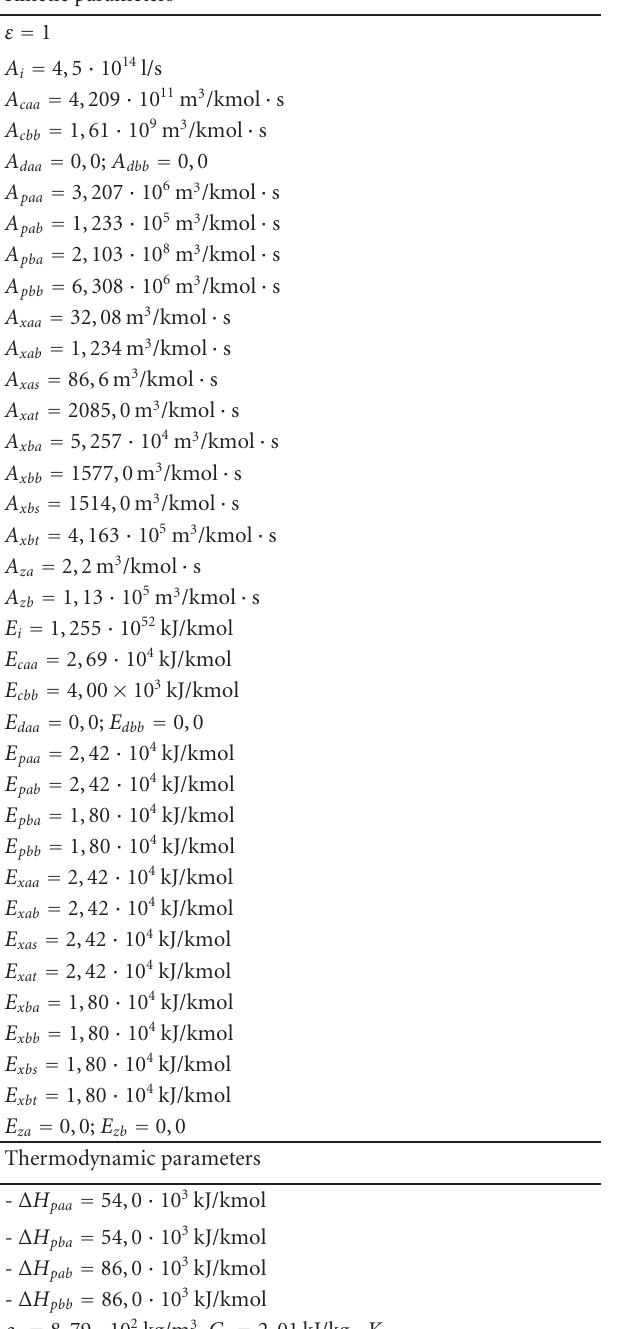
Table 8: Kinetic and thermodynamic parameters for deterministic